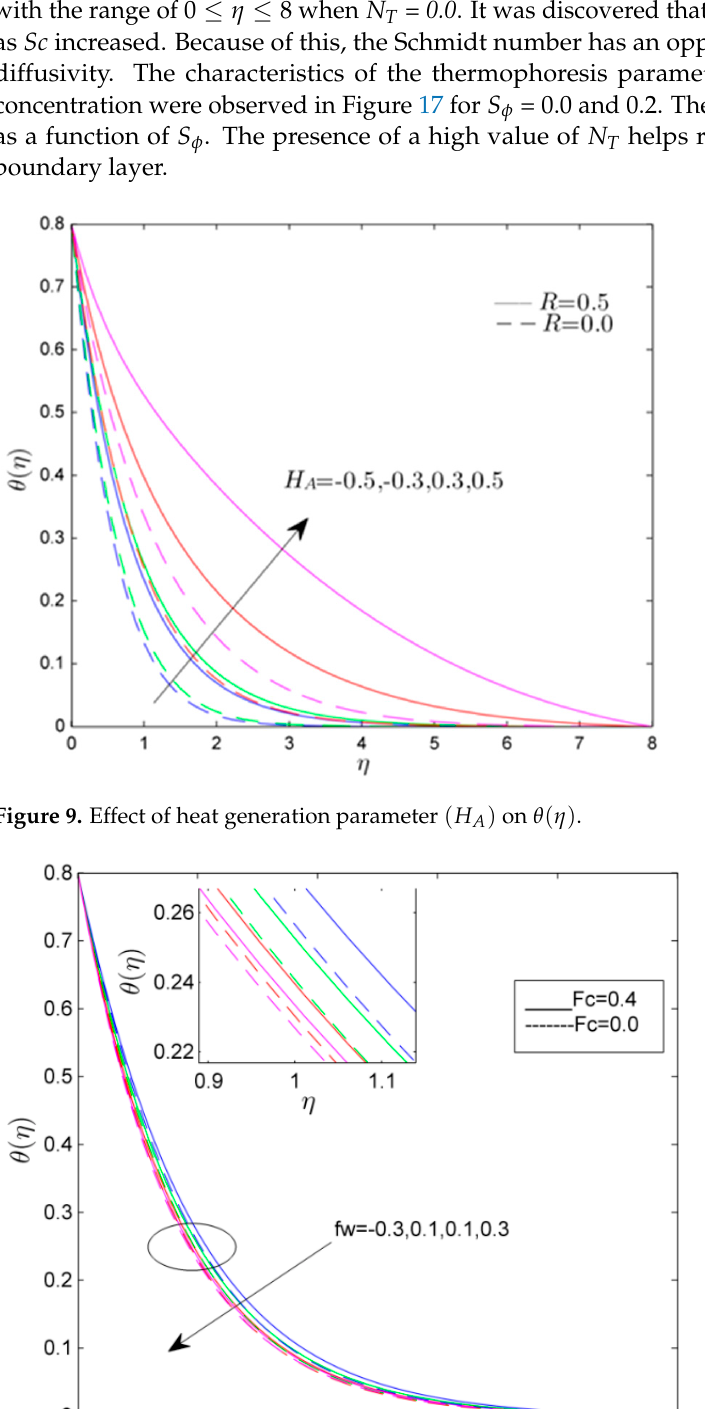
Figure 10. Effect of suction/injection parameter (𝑓𝑤) on 𝜃(𝜂) .